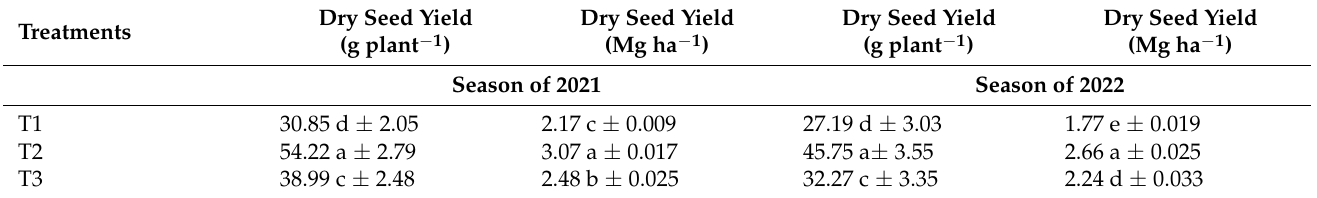
Table 6. Total dry yield of common bean seeds as influenced by different treatments. Results from the field experiments, and where T1 = negative control, T2 = 100 ppm nano-Se, T3 = 200 ppm nano- SiO 2 , T4 = 1/2 nano-Se + SiO 2 , and T5 = fungicide (Score 250 EC at 1 mL/2 L). Treatments